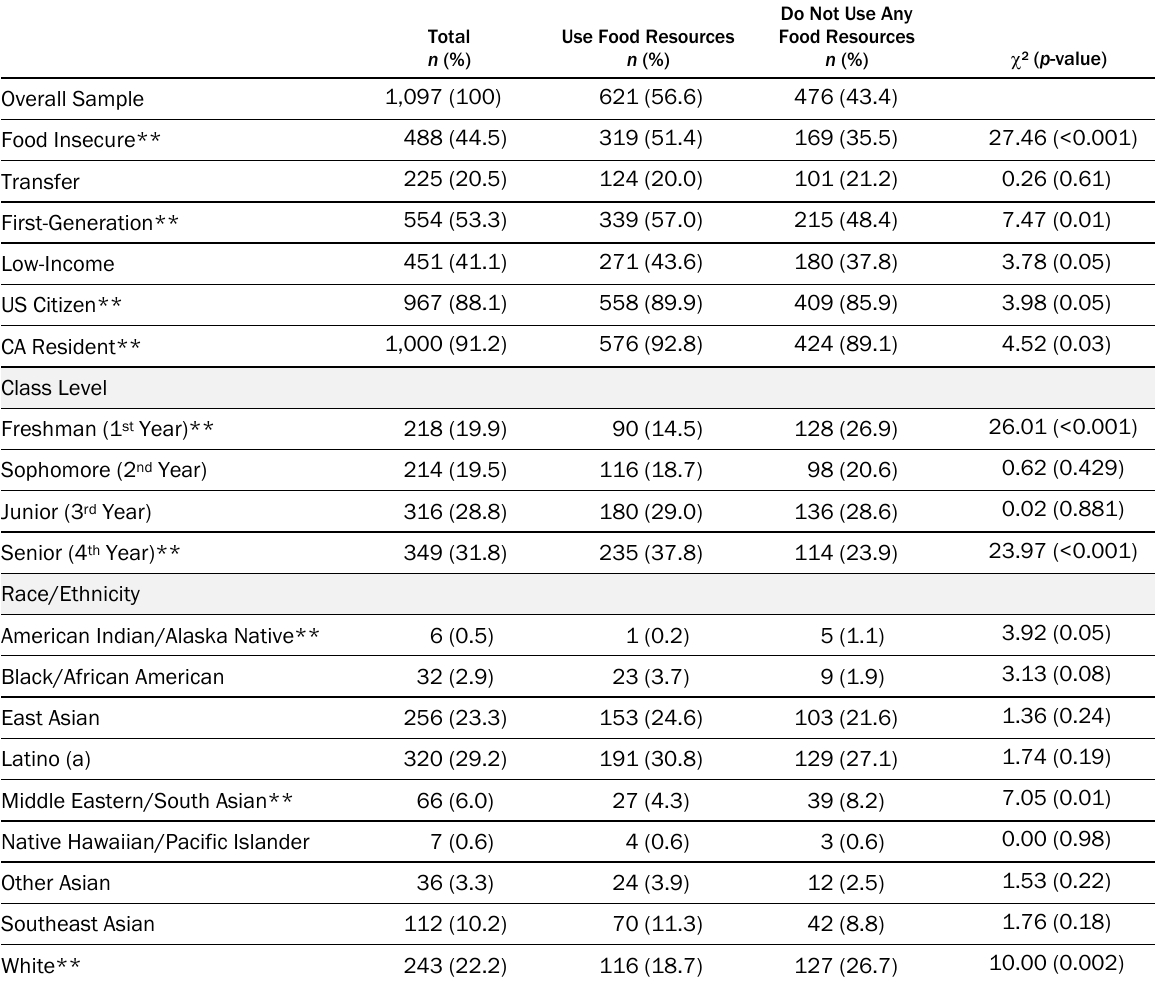
Table 2. Chi-Square Test of Campus Food Resource Participation